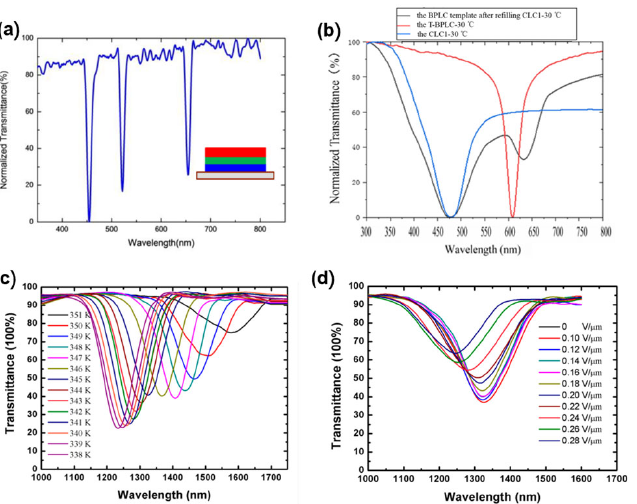
Figure 7. ( a ) The red/green/blue filter with a multi-layer blue phase liquid crystal; reproduced from Ref. [81]. MDPI, 2019. ( b ) Transmission spectra of multi-wavelength LC filter based on the BPLC template; reproduced from Ref. [82]. MDPI, 2021. ( c ) Transmission spectra of the NIR filter at different temperatures; ( d ) electric field dependence of the transmittance on the NIR filter at 345 K. Reproduced from Ref. [83]. MDPI, 2019.